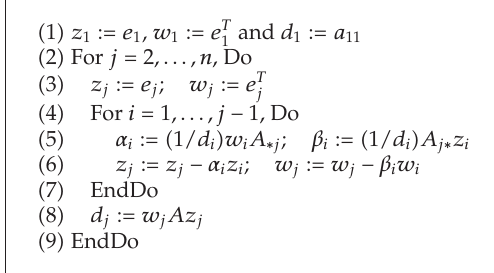
Algorithm 1: The FFAPINV algorithm without